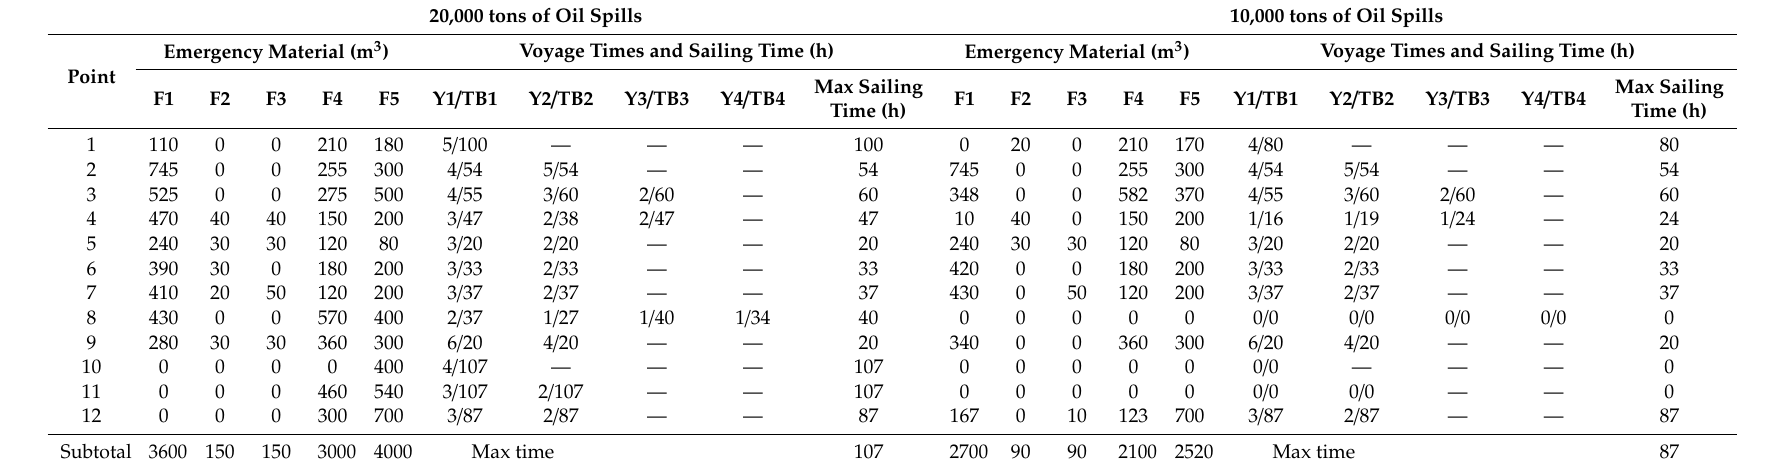
Table 3. Optimized dispatching schemes of emergency materials for 20,000 tons and 10,000 tons.